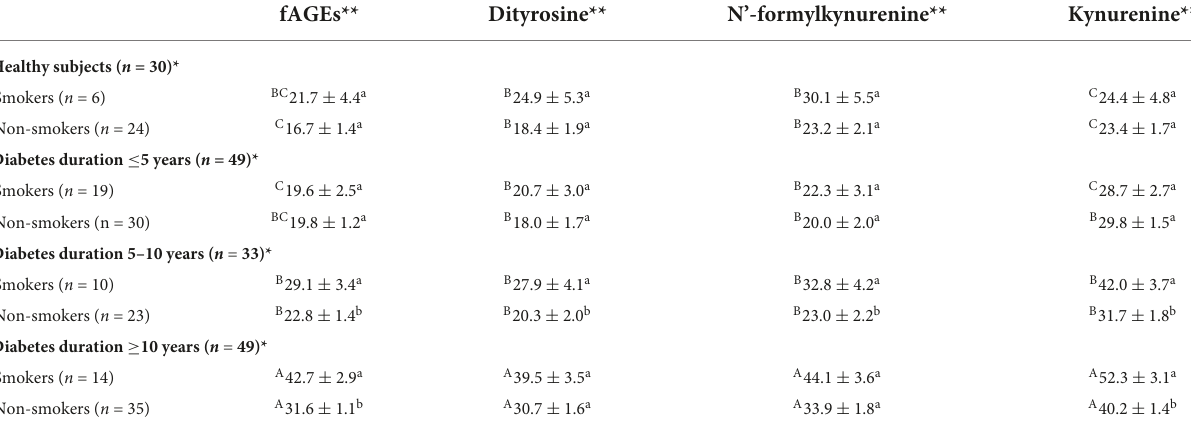
TABLE 3 Fluorescence intensities of advanced glycation end products (AGEs) and protein oxidation products (POPs) in smokers and non-smokers with type 2 diabetes mellitus (T2DM). fAGEs** Dityrosine** N’-formylkynurenine**